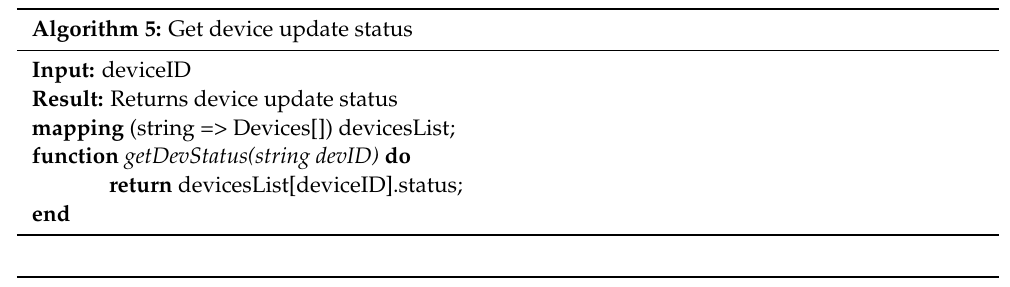
Algorithm 5: Get device update status